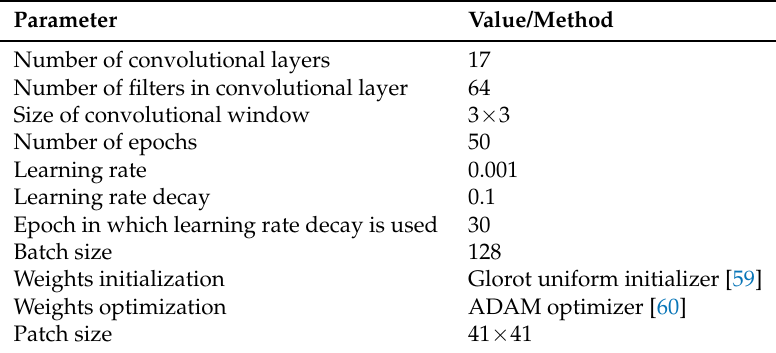
Table 1. Summary of the network parameters.